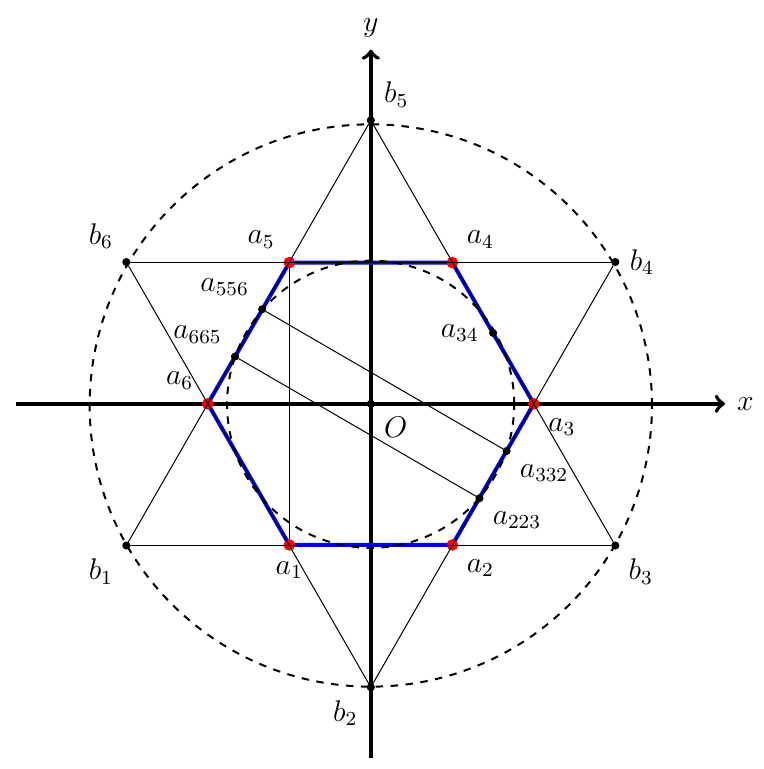
Figure 1: Geometrical elements to define Wachspress shape functions on a regular